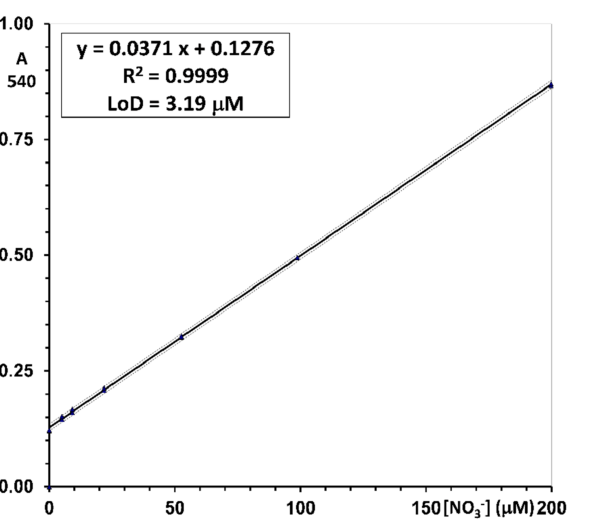
Figure 3. An example of a daily standard curve for nitrate measurement with the reported equation, goodness-of-fit, and Lower Limit of Detection (LoD). Confidence limits of ± 1.6 µ M are highlighted by the dashed lines. Analytical conditions are described in the Materials and Methods